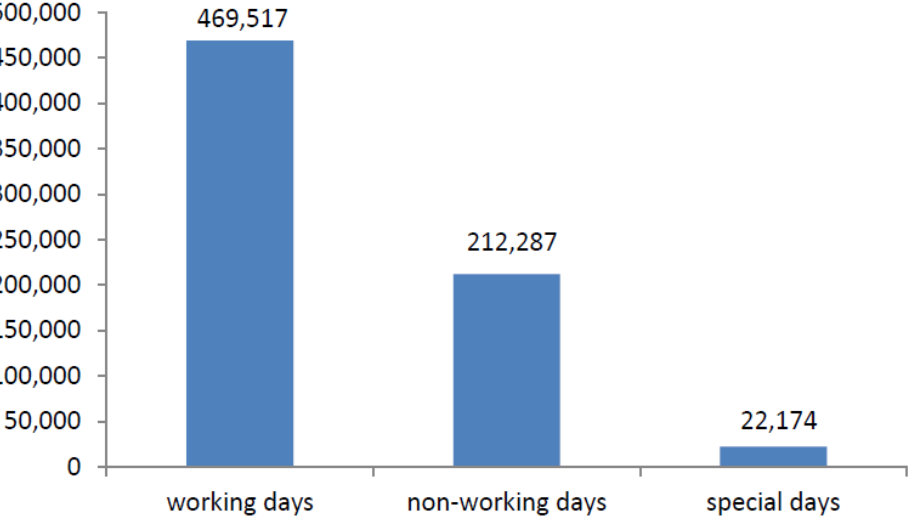
Figure 6. Distribution of original data samples in terms of day type from 1 September 2010 to 29 February 2012.